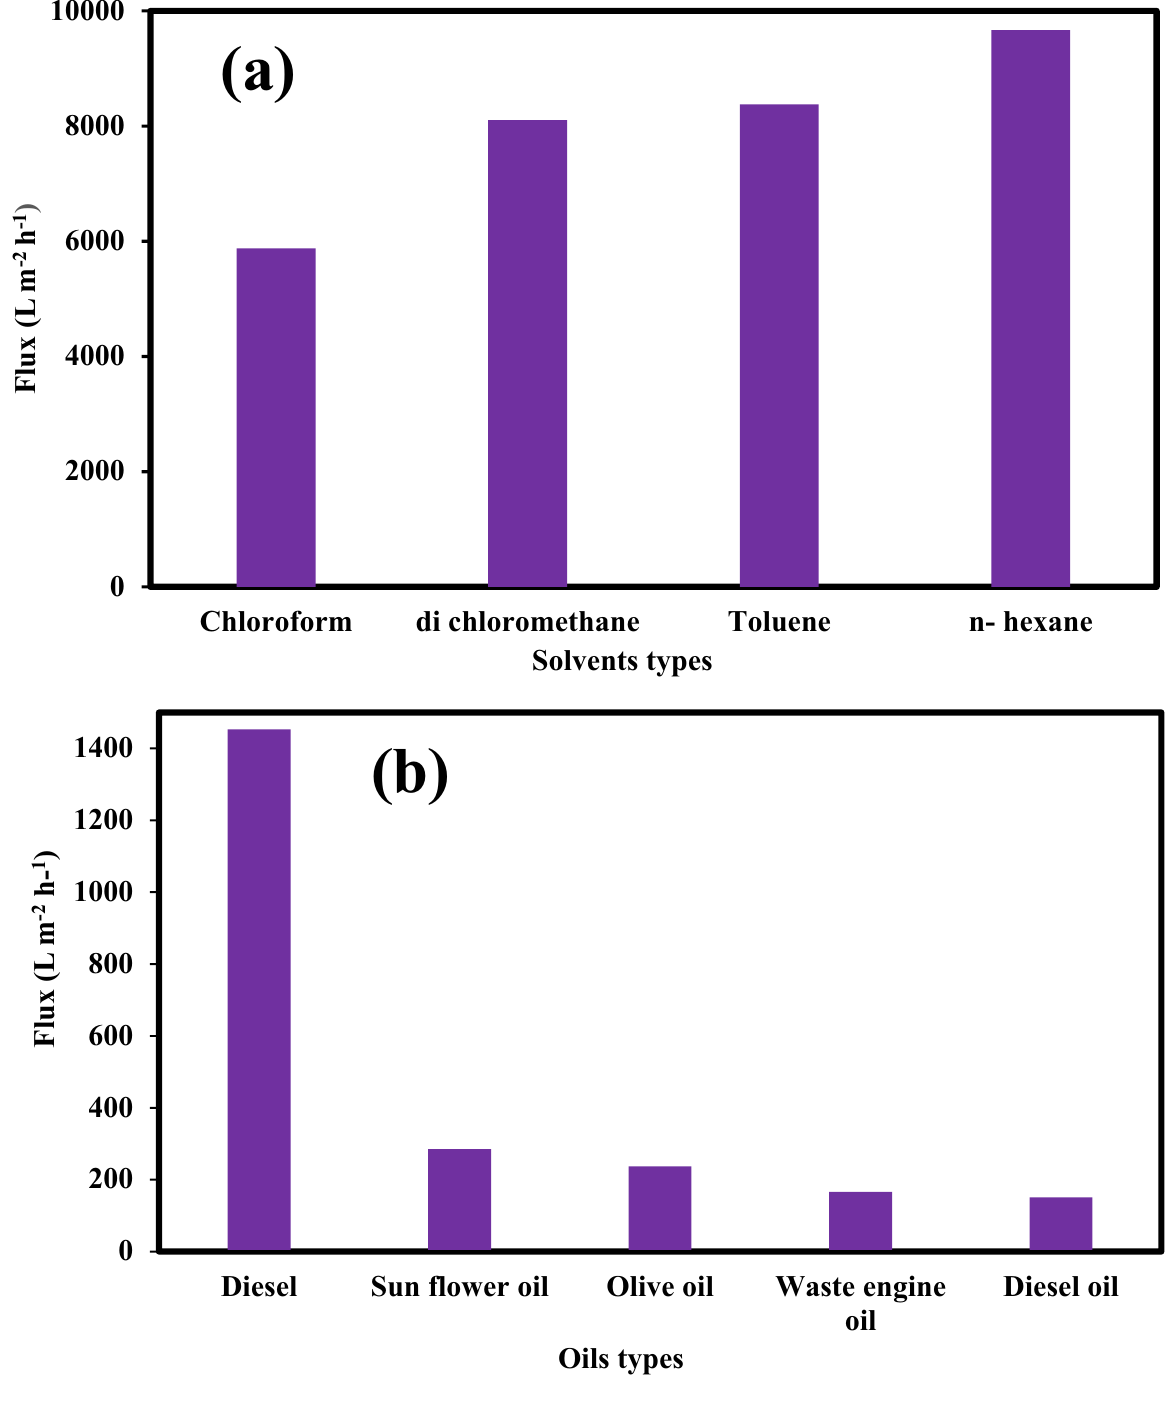
Figure 7. Flux of the modified surface cellulosic filter papers ( a ) low viscous and ( b ) high viscous organic